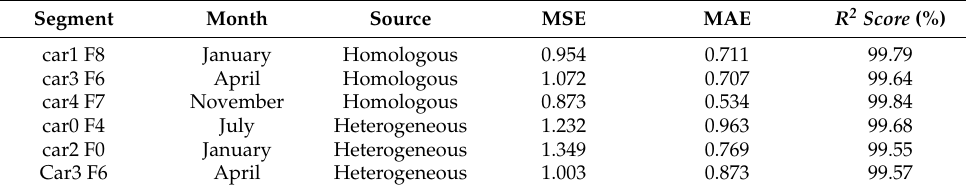
Table 6. Comparison of accuracy of different vehicles or seasonal test